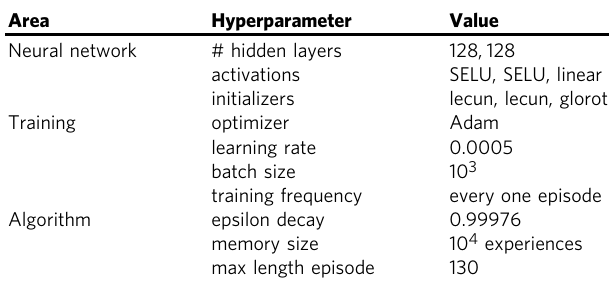
Table 1 List of the hyperparameters and their values used in the fi xed-target problem. We used the scaled exponential linear units (SELU) as nonlinear activation functions in the hidden layers of the neural